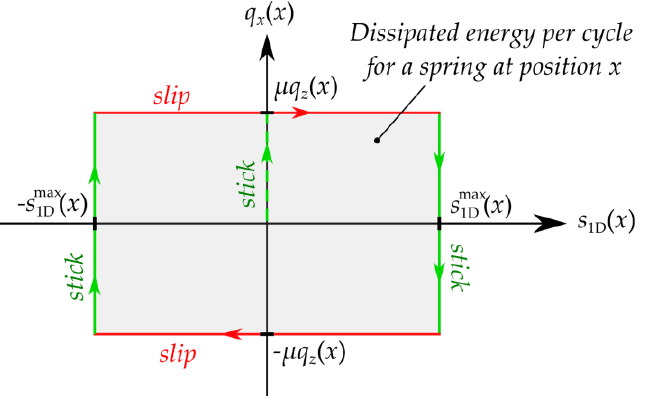
Figure 10. Hysteresis curve and energy dissipation of a parabolic indenter for a fixed elastic inhomogeneity k and various quotients of the characteristic depth c 0 / a 0 : ( a ) Tangential force over tangential displacement for k = − 0.5; ( b ) Energy dissipation over the traction ratio F A ( c ) Tangential force over tangential displacement for k = 0.5; ( d ) Energy dissipation over the traction ratio F A for k = 0.5. µ F N